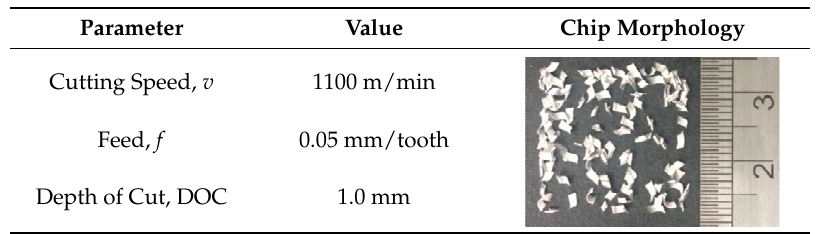
Table 2. Selected milling parameter.